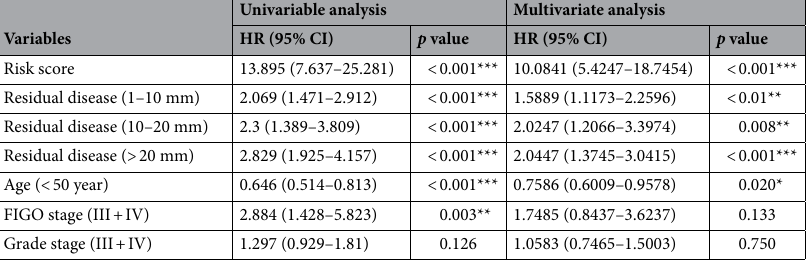
Table 1. Univariable and multivariate cox regression analysis of factors affecting overall survival of SOC patients. HR, Hazard Ratio; CI, Confidence Interval. * p < 0.05; ** p < 0.01; *** p <